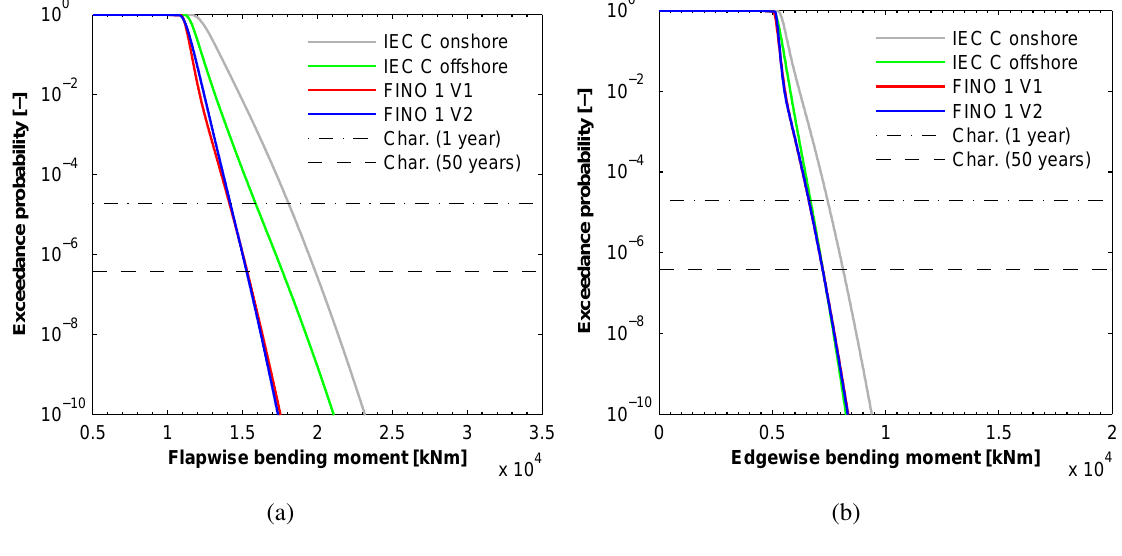
Figure 7. Long-term exceedance probability distribution of the bending moments at the blade root calculated by means of the ACER method. ( a ) Flapwise; ( b ) Edgewise.